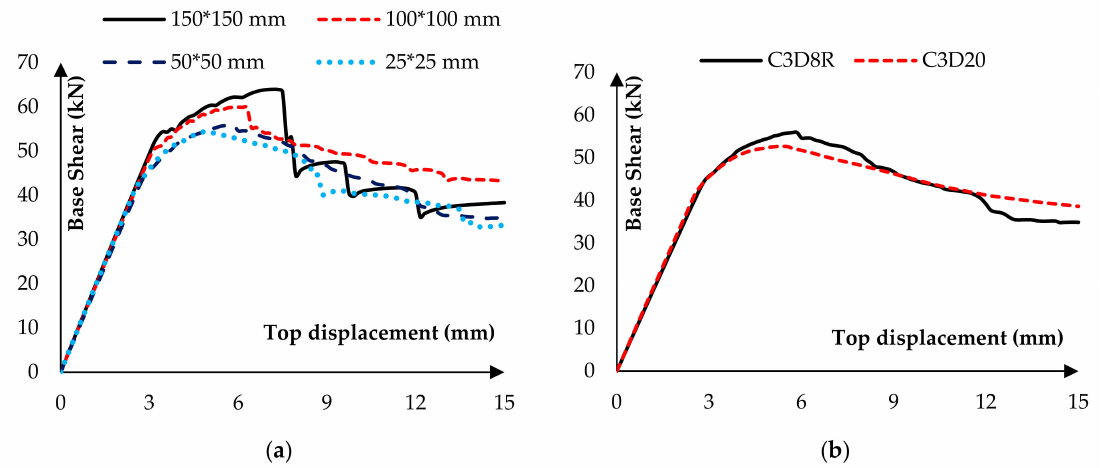
Figure 11. Comparison of different models to validate sensibility ( a ) different sizes ( b ) different